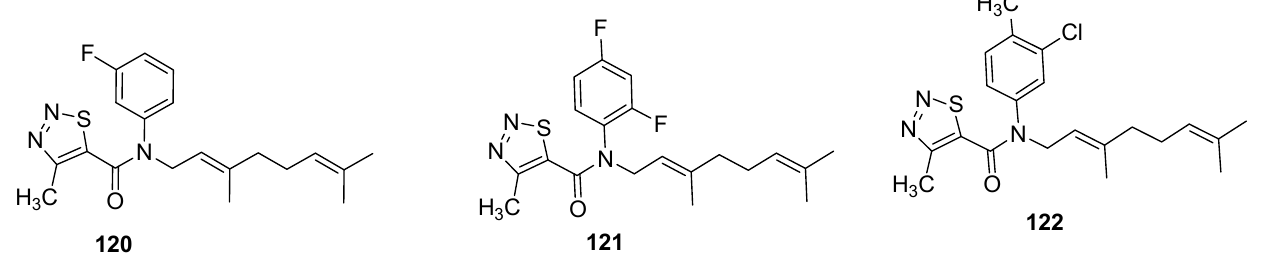
124 Figure 20. Ethers of pyrazole oximes 123 and 124 with insecticidal properties. Another interesting example of insecticidal compounds are hybrids of substituted triazole and 1,2,3-thiadizole scaffold that were investigated for their activity against Aphis laburni and TMV by Li et al. [135] . Preliminary bioassays indicated compounds 125 and 126 (Figure 21) as lead compounds by depicting enhanced activity against Aphis laburni at 100mg/mL (mortality ≥ 95%) while the derivative 127 represent the least active com- pound (due to CF 3 substituted triazole ring) that displayed only 25.25% mortality. The structure–activity study indicated that scaffolds with aromatic moieties attached to the carbonyl carbon of triazole ring have higher insecticidal activity than scaffolds with alkyl moieties [135] . N N SCH 3 N NN S O